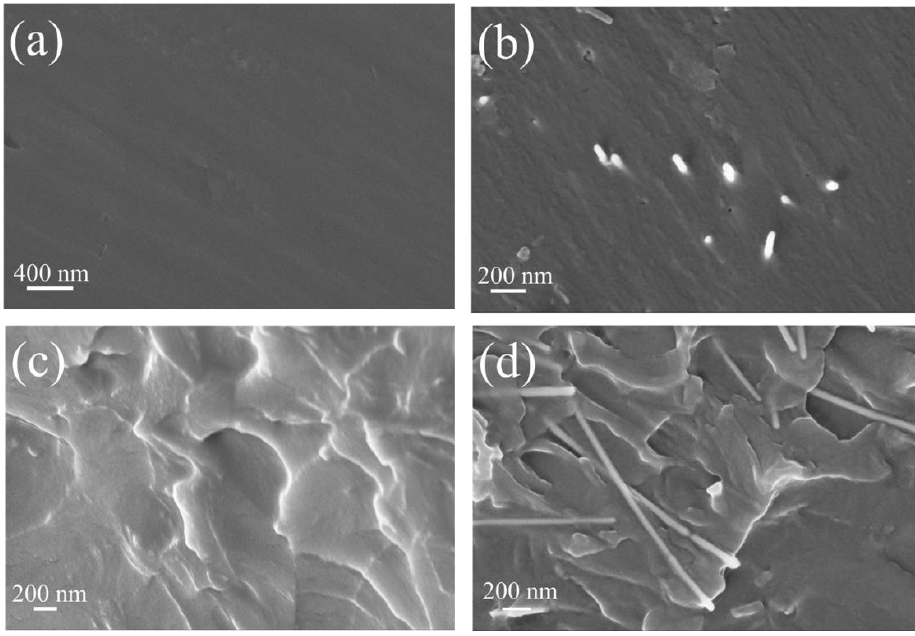
Figure 5. Representative SEM images of the epoxy-based composite showing cross sections of ( a ) pure epoxy, ( b ) AgNW filler, ( c ) GO nanosheet filler, ( d ) AgNW/GO hybrid filler.